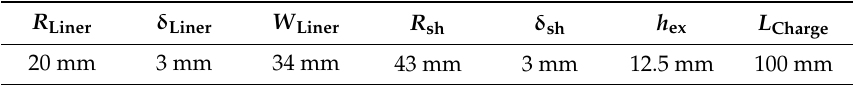
Figure 2. The linear-shaped charge used in the experiment: ( a ) Main charge; ( b ) arc liner used in the experiment. Table 1. Parameters of the LSC